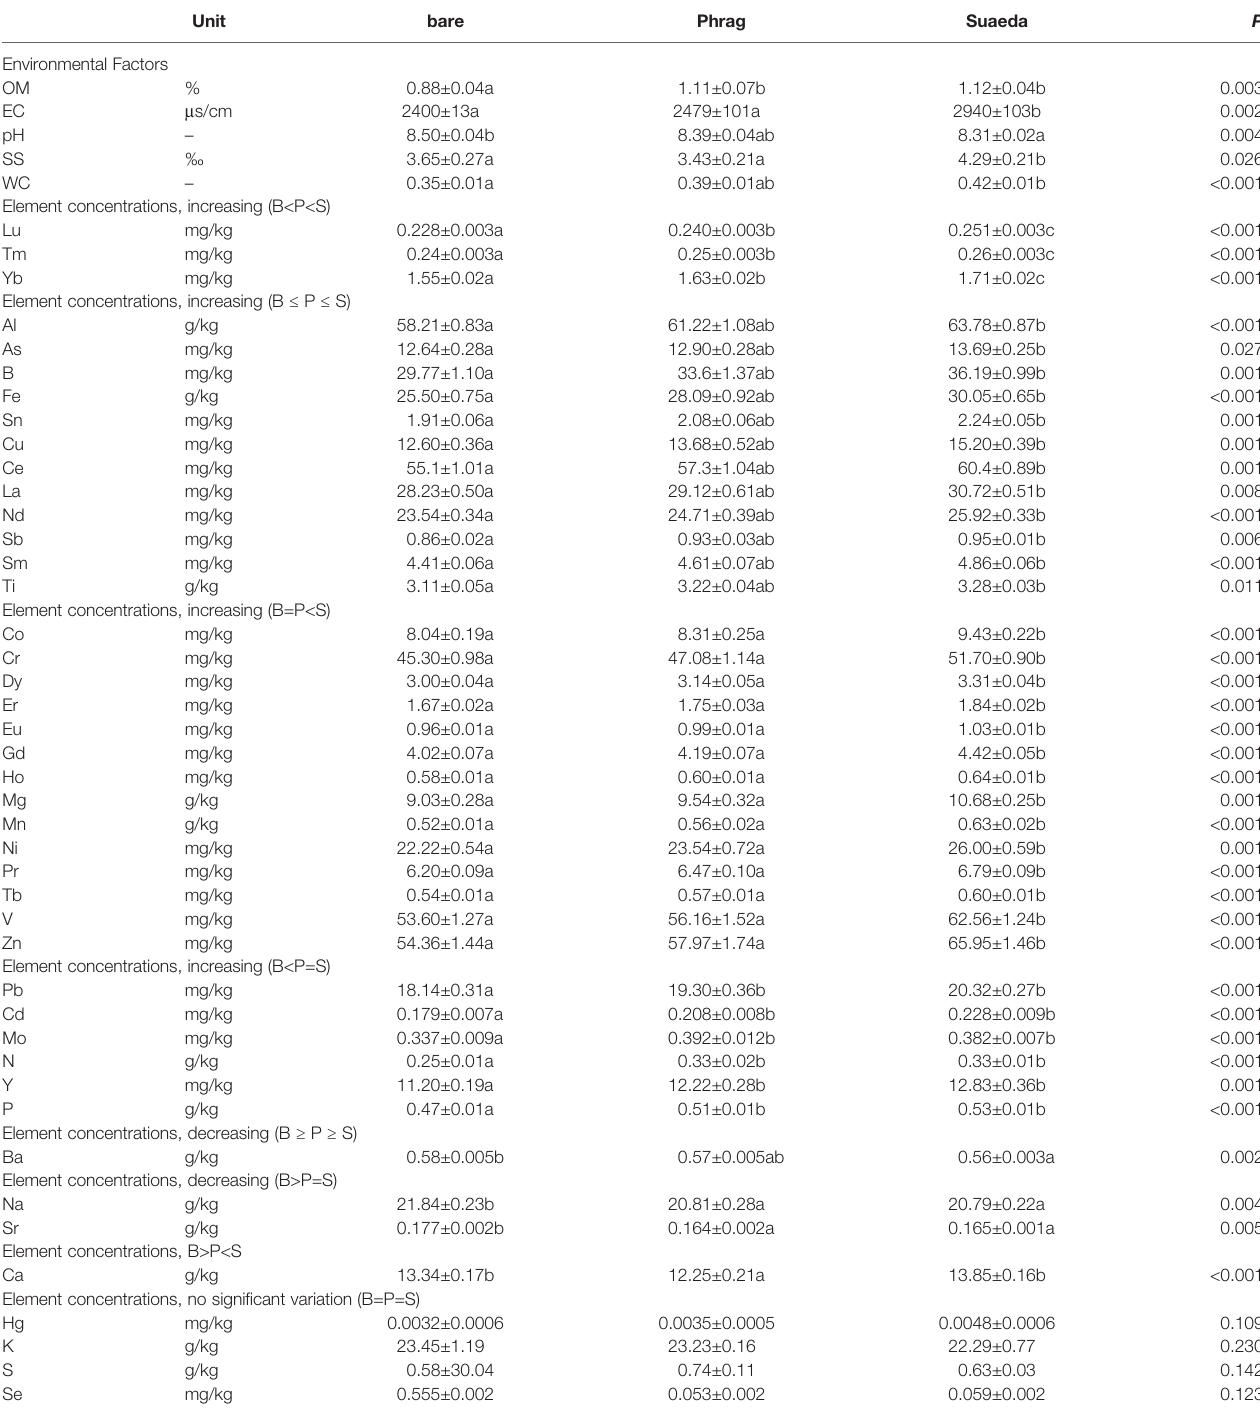
Different letters indicate signi fi cant differences in means ( P <